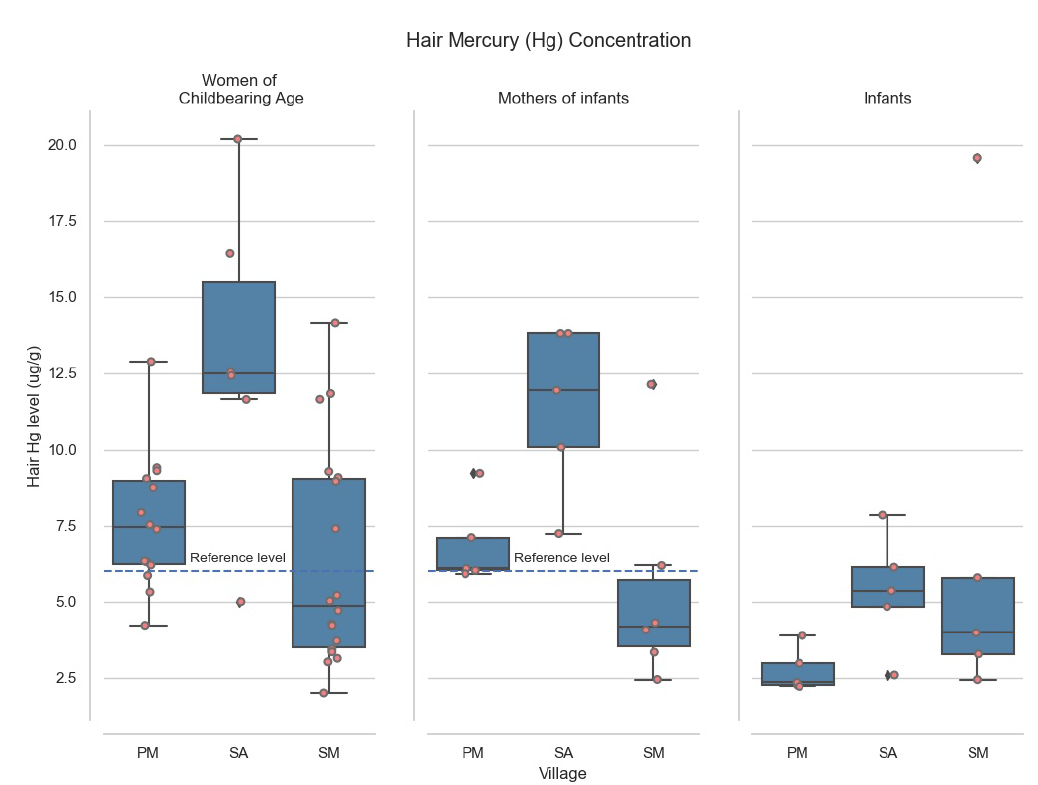
Figure 2. Methylmercury levels split by villages. PM correspond to Poxo Muybu village; SA is Sawré Aboy and SM is Sawré Muybu . Sawré Muybu Indigenous Land, Brazilian Amazon, 2019.